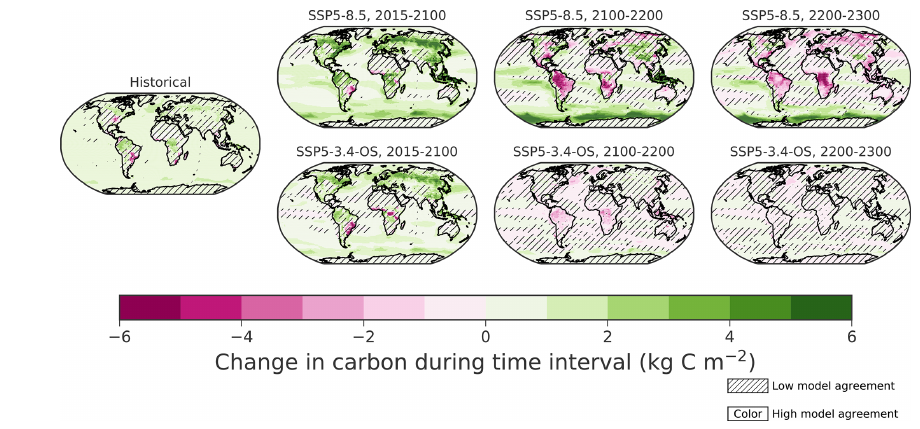
Figure 8. Maps of ensemble mean projected carbon change for different scenarios and time periods. Carbon change is calculated as the time integral of carbon fluxes (on land) and time integral of flux anomalies relative to the first 20 years of historical simulation (on ocean). Hatching indicates that less than 83% (five of six) of models agree with the ensemble mean on the sign of the carbon change. Positive flux represents a net carbon